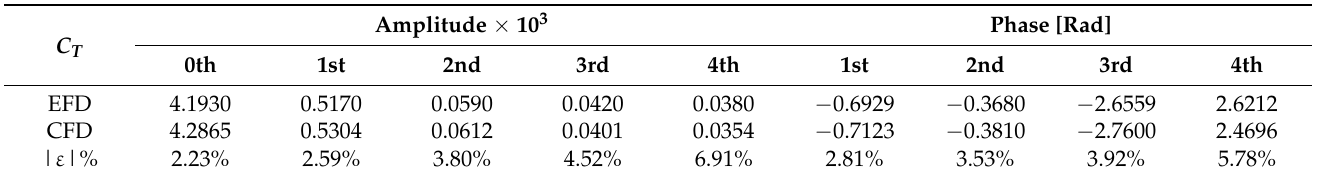
Table 24. Harmonic amplitudes and phases of the total resistance coefficient ( C T ) for the FRxz ϕθ following waves scenario.